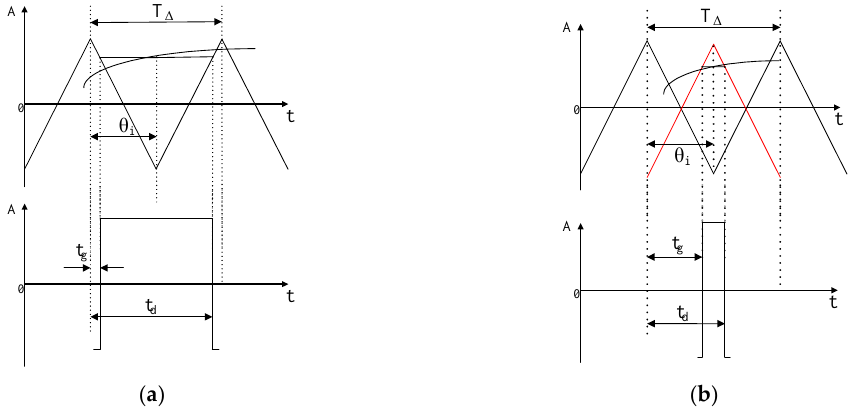
Figure 5. Pulse control signal calculation principle: ( a ) S 11 ; ( b ) S 13 .